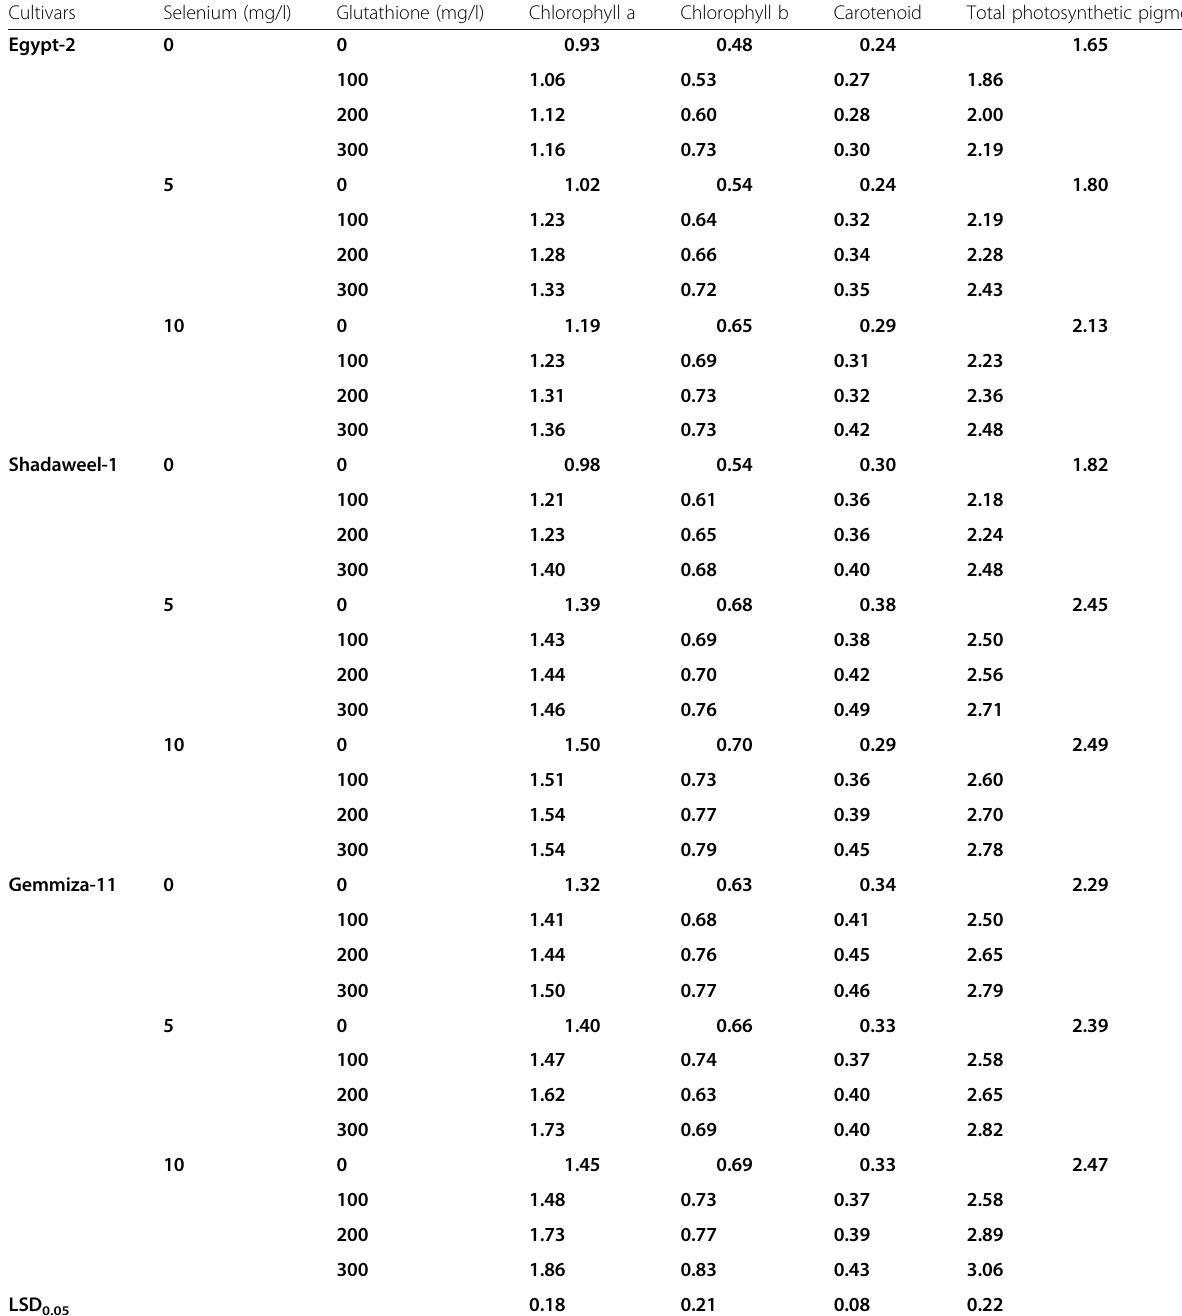
spikelets/spike, biological yield/teller, grain yield/teller,